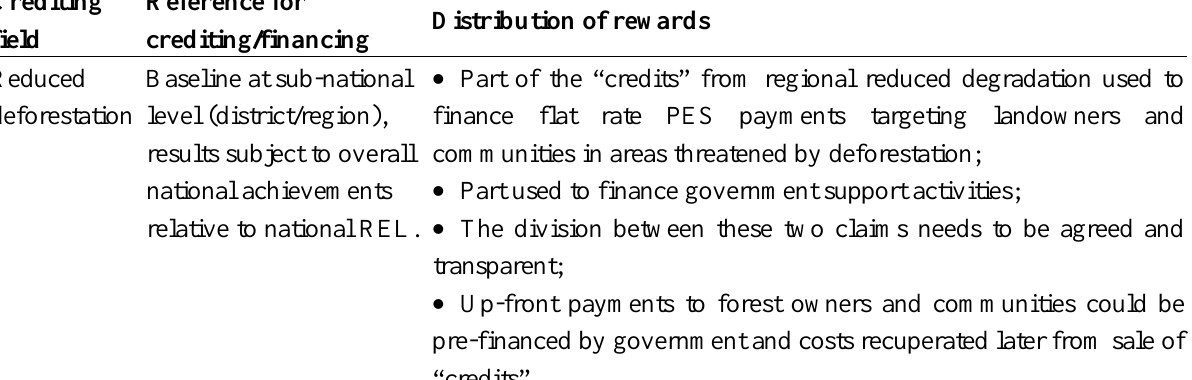
Table 3. Proposed mixed scheme for the distribution of rewards in a national REDD+